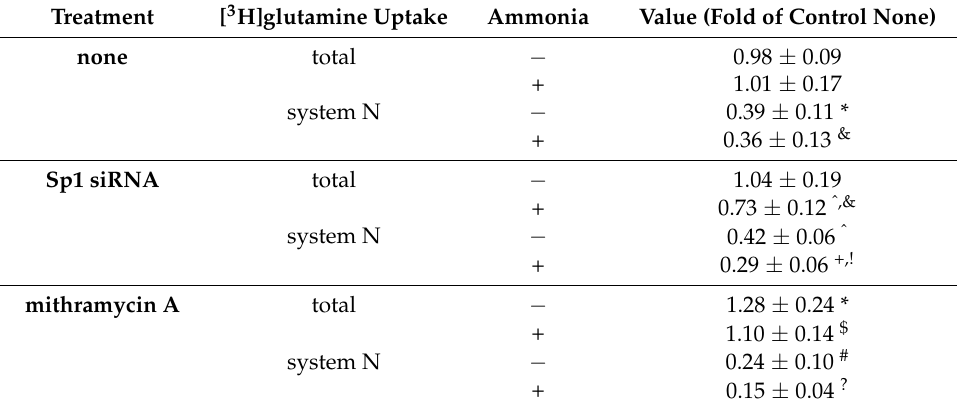
Table 1. Total and system N-mediated [ 3 H]glutamine uptake in mouse cortical astrocytes after 5 mM ammonia exposure for 24 h and silencing of Sp1 transcription factor by 5 nM siRNA or its inhibition by 10 µ M mithramycin A. Basal [ 3 H]glutamine uptake for control cells was 8.02 ± 1.43 nmol/mg of protein/min. Control—ammonia − ; 5 mM ammonia treatment—ammonia+. Results are mean ± SD ( n = 4). (*) p < 0.05 vs. control none (total), ( # ) p < 0.05 vs. control none (system N), ( & ) p < 0.05 vs. ammonia none (total), ( ˆ ) p < 0.05 vs. control Sp1 siRNA (total), ( ! ) p < 0.05 vs. ammonia Sp1